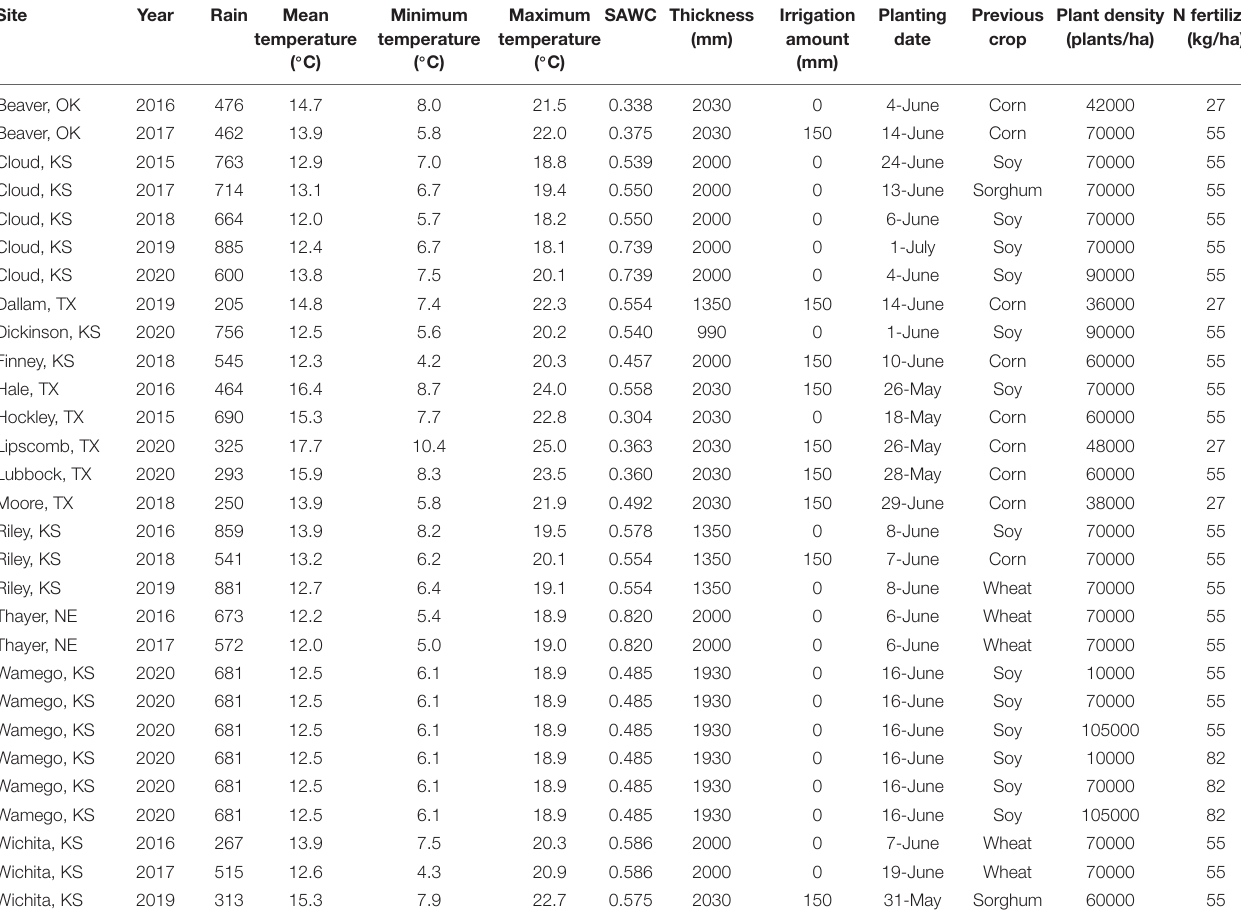
TABLE 2 | Detailed field experiments on sorghum conducted for model parameterization and